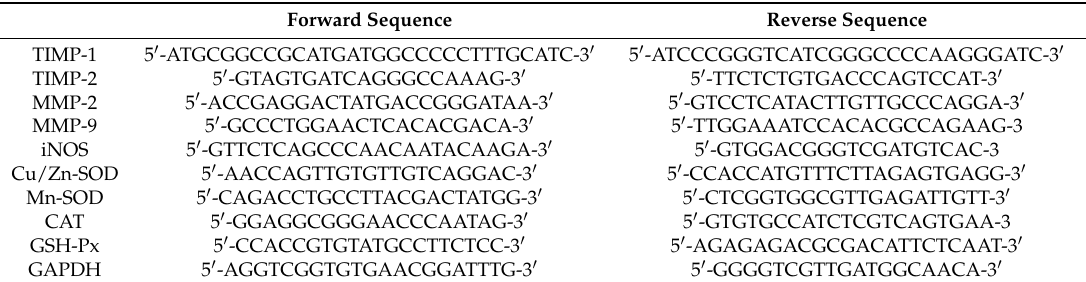
Table 6. qPCR assay